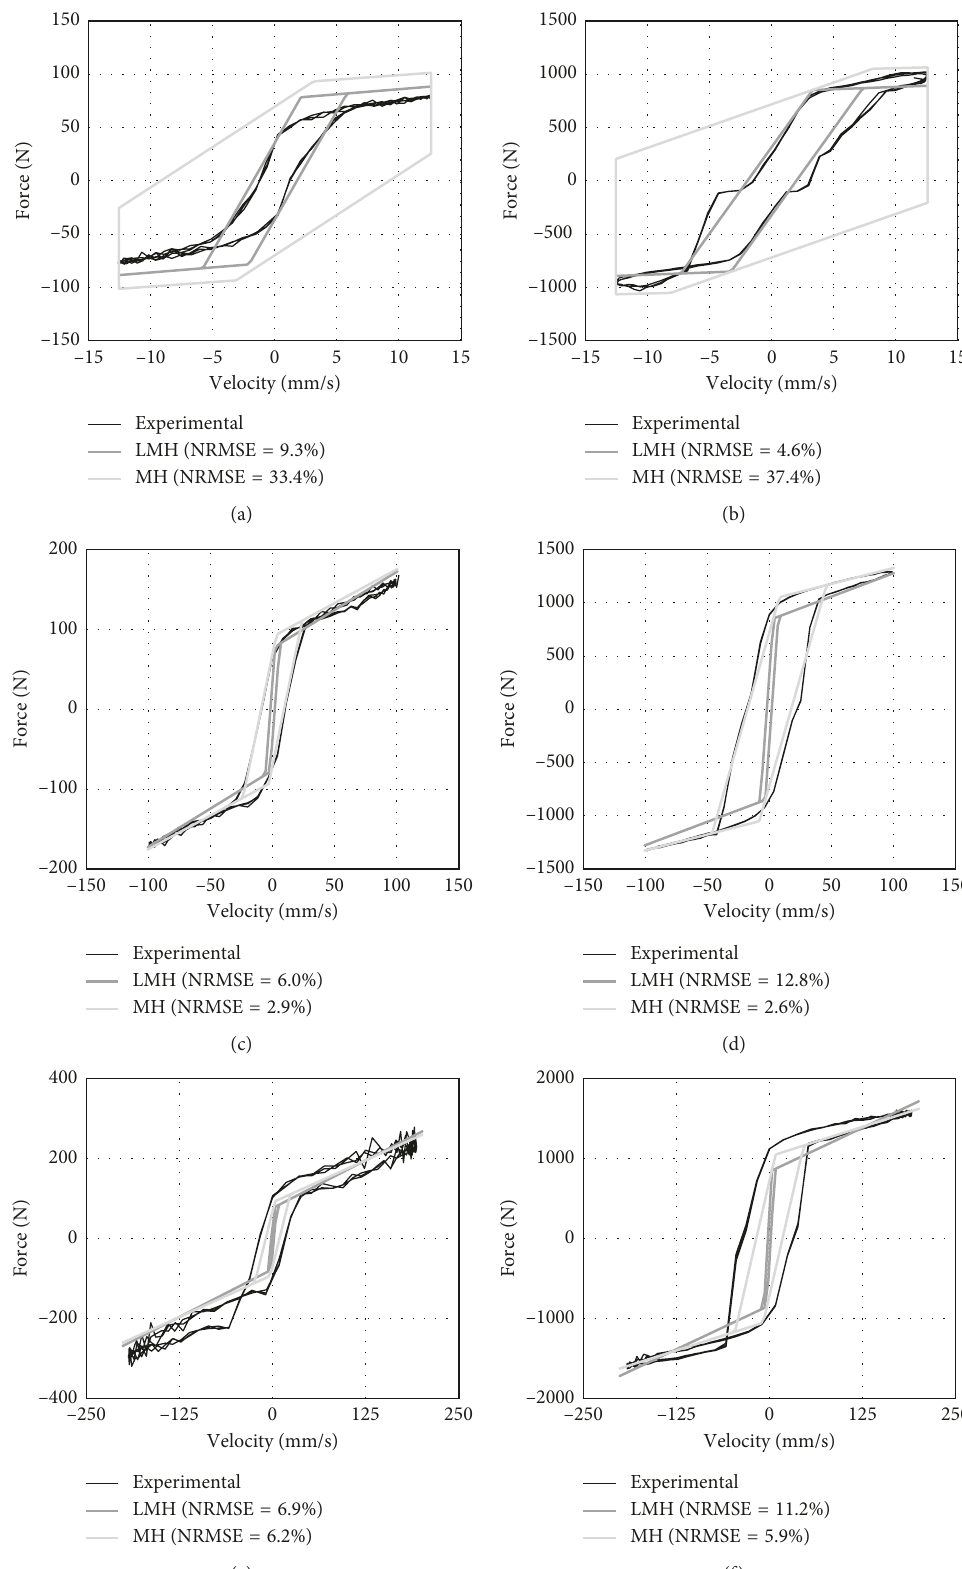
Figure 11: Hysteretic biviscous model (fitted with LMH and MH tests) predictions for six different tests: (a) low velocity without intensity; (b) low velocity with I 1A; (c) medium velocity without intensity; (d) medium velocity with I (cid:31) high velocity with I (cid:31)